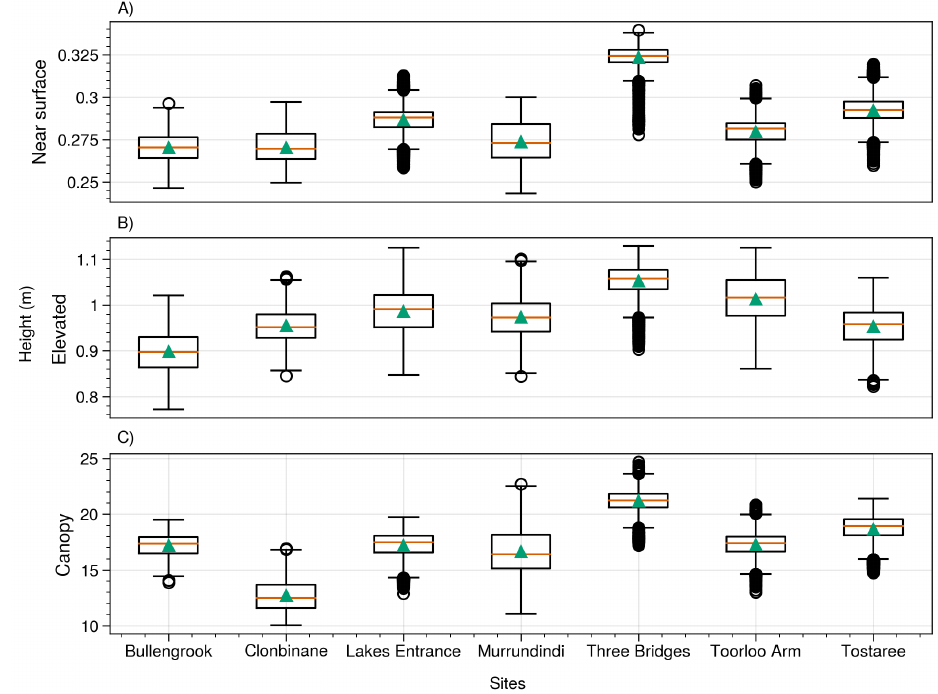
Figure 10. Box plots showing mean prediction of height from the random forest models trained with TLS observations for ( A ) near-surface ( B ) elevated ( C ) canopy layers at all